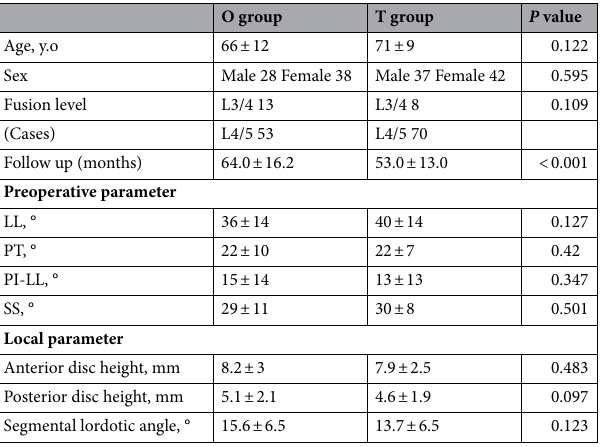
Table 1. Demographic characteristics. LL indicates lumbar lordosis; PT pelvic tilt, PI-LL pelvic incidence minus lumbar lordosis, SS sacral